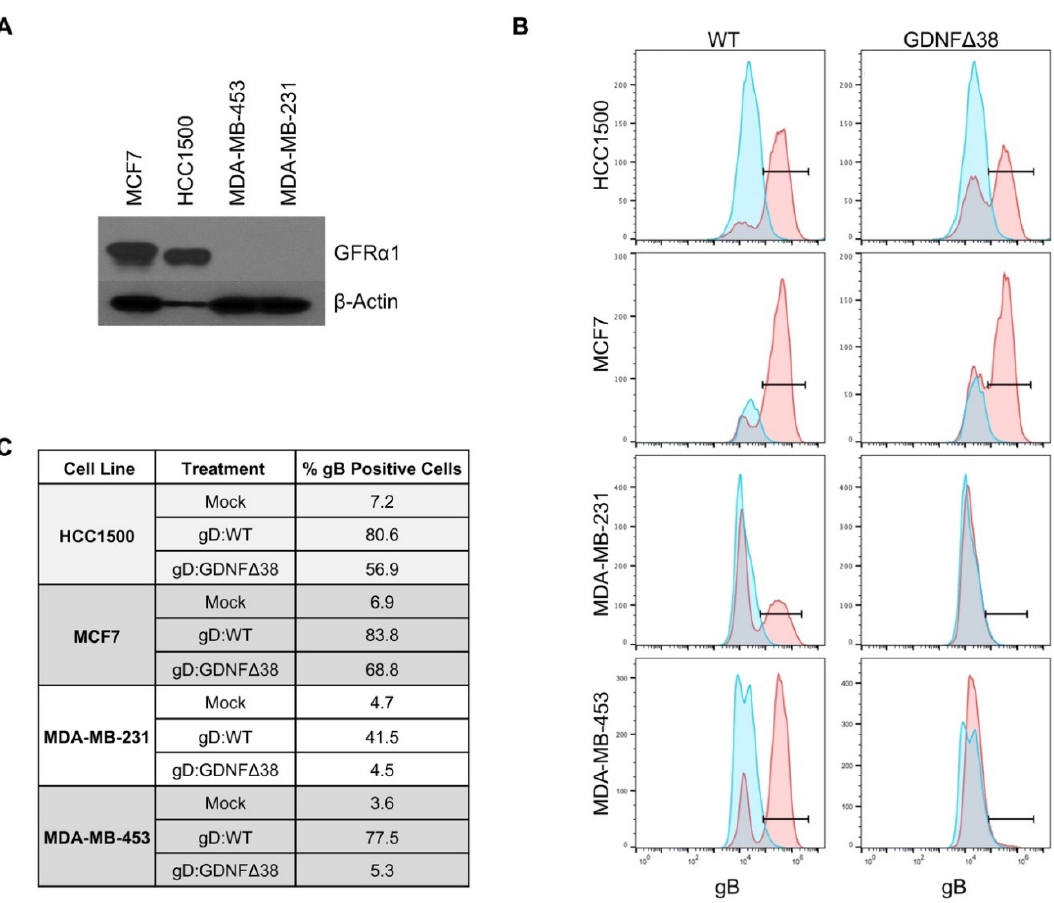
Virus infection of breast cancer cell lines. ( A ) MCF7, HCC1500, MDA-MB-231, and MDA-MB-453 cell lines were assessed for GFR α 1 expression by Western blot analysis of whole cell lysates; β -actin detection was used as a loading control. ( B ) HCC1500, MCF7, MDA-MB-231, and MDA-MB-453 cells were infected with KNTc-gD:GDNF ∆ 38 or KNTc-gD:wt virus at 3 pfu / cell and flow cytometry for gB protein on the cell surface was performed at 24 hpi. For each cell line, uninfected cells are shown in blue compared to virus infected cells in red; KNTc-gD:wt infected cells (WT) and KNTc-gD:GDNF ∆ 38 infected cells (GDNF ∆ 38). ( C ) Quantification of gB + cell populations as a percent of the total analyzed cells for each treatment group.